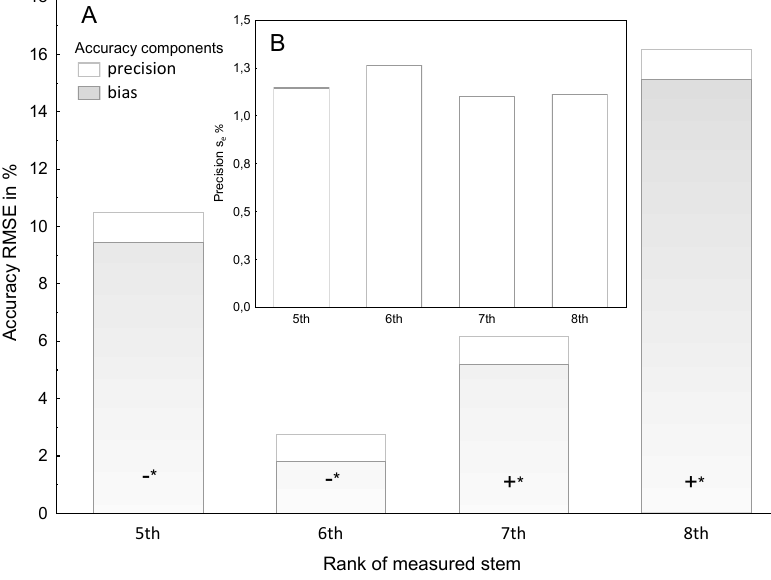
Figure 1. Comparison of accuracy ( A ); and precision ( B ) for one-measurement variants of Weise’s estimation averaged across all examined stands. The stacked accuracy bars representing averaged proportions of bias ( grey ) and precision ( white ) in terms of accuracy were calculated as ratios of squared bias/precision on squared RMSE. Signs in the bias proportions shows the prevalent direction of original biases (under- or overestimation). The signs denoted by an asterisk indicate the prevalence of statistically significant biases at a p -value of